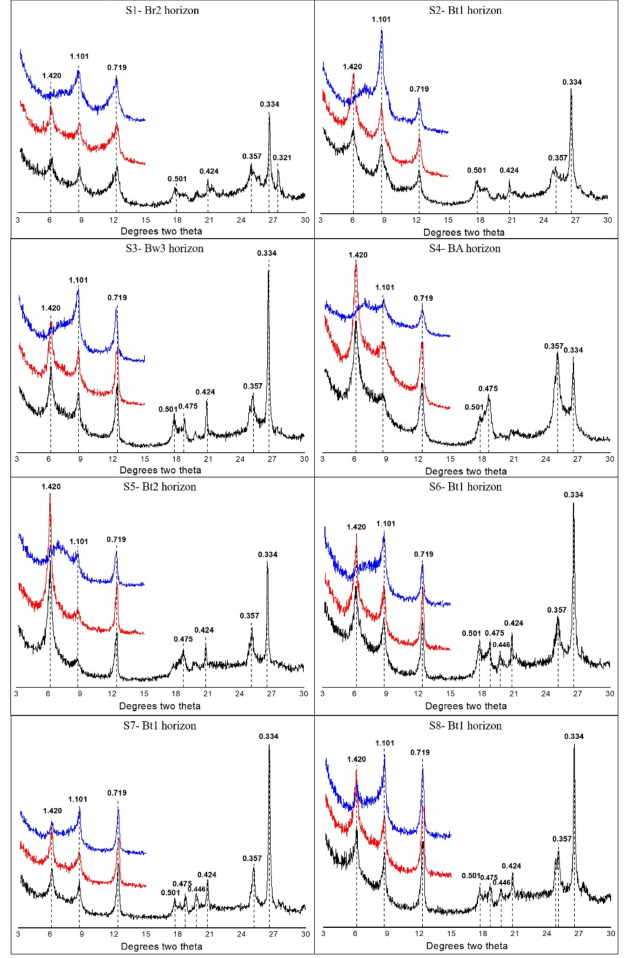
Figure 4. Examples of XRD patterns in the clay fraction samples of middle horizons for each soil pedon. The sequence of treatments is represented by three different colors. Black patterns ( bottom ) are glycol-solvated (EG) samples. Red patterns (middle position) were analyzed as air-dried mounts’ (AD) samples. Blue patterns ( top ) are glycol-solvated samples heated at 550 ◦ C (K550). All d-values assigned to peaks are in nm (10 − 9